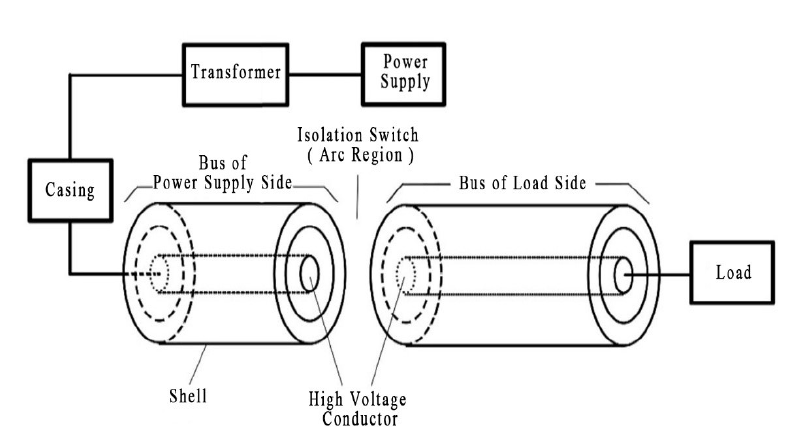
Figure 1. GIS line structure model diagram. In the process of isolating the switch operation, the voltage difference between the dynamic and static contacts is greater than the insulation withstanding voltage of the SF 6 medium, the gap is broken down, and the arc is generated. When the rising speed of the recovery voltage between the two contacts after the arc extinguishing is greater than the insulation recovery strength of the SF 6 medium, arc reignition will occur, as shown in Figure 2.